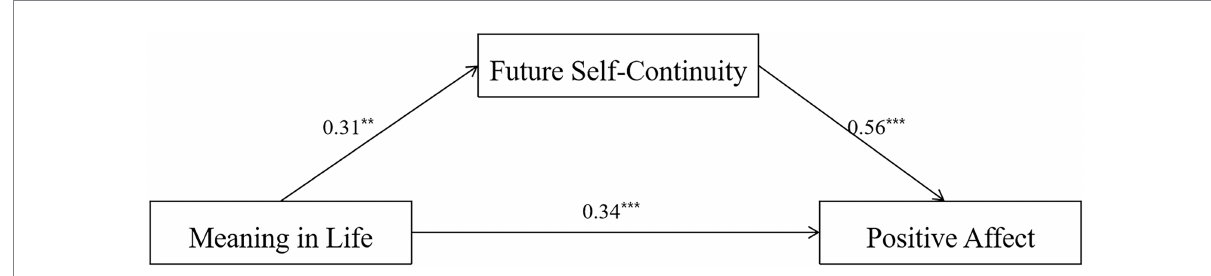
FIGURE 1 Mediational pathways of MIL on PA. ** p < 0.01, *** p < 0.001.